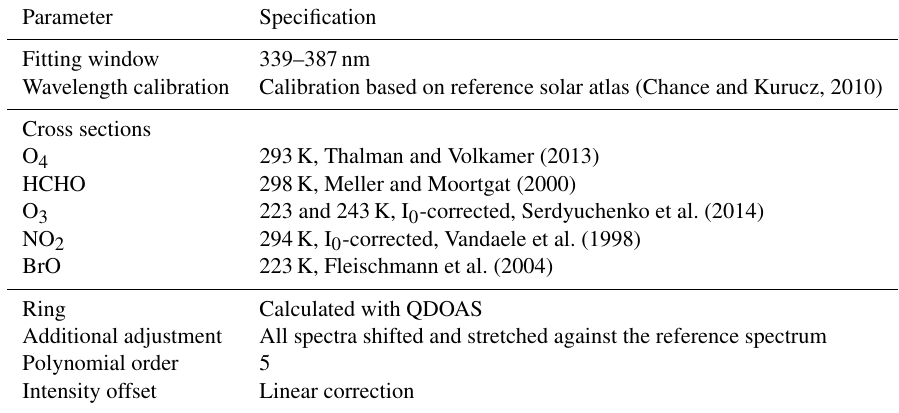
Table 1. DOAS retrieval settings for O 4 . Parameter Specification Fitting window 339–387nm Wavelength calibration Calibration based on reference solar atlas (Chance and Kurucz, 2010) Cross sections